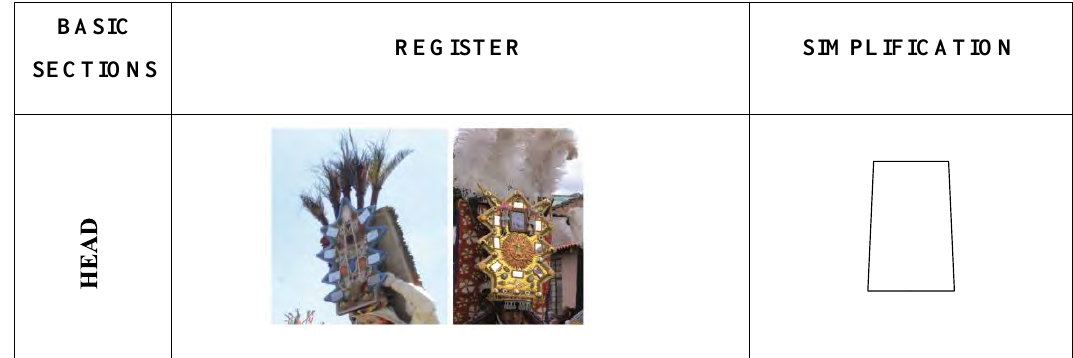
Table 3. Pre iconographic